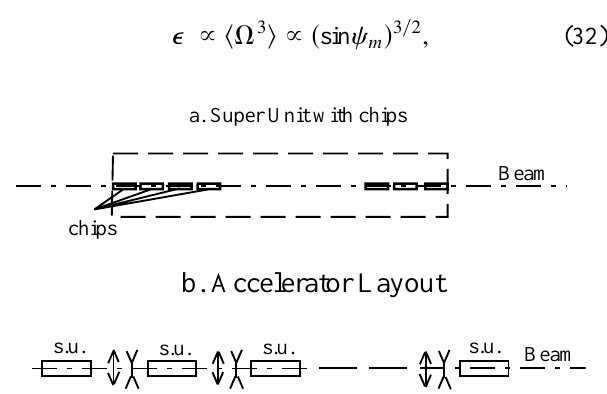
FIG. 3. Chip model. (a) A superunit with chips and (b) the chip model accelerator